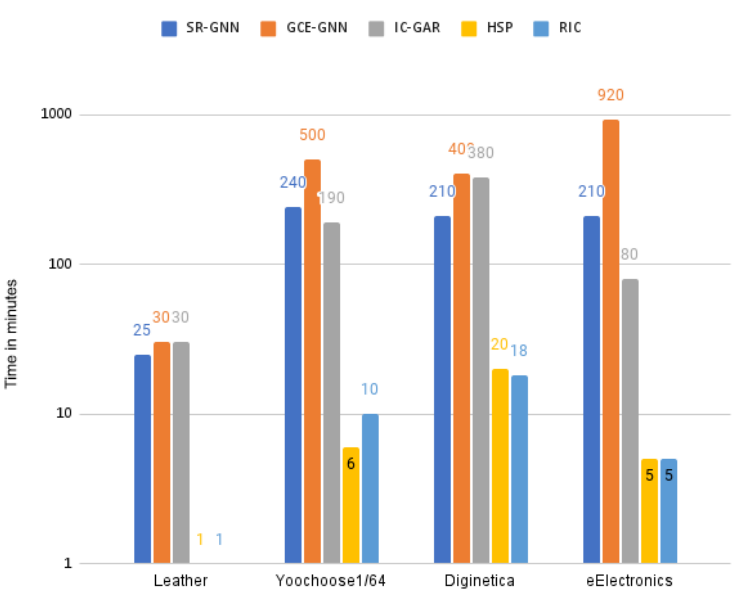
Figure 4. The execution time in minutes for all methods and each dataset. Our proposed methods are between 10 × and 180 × times faster than GNN